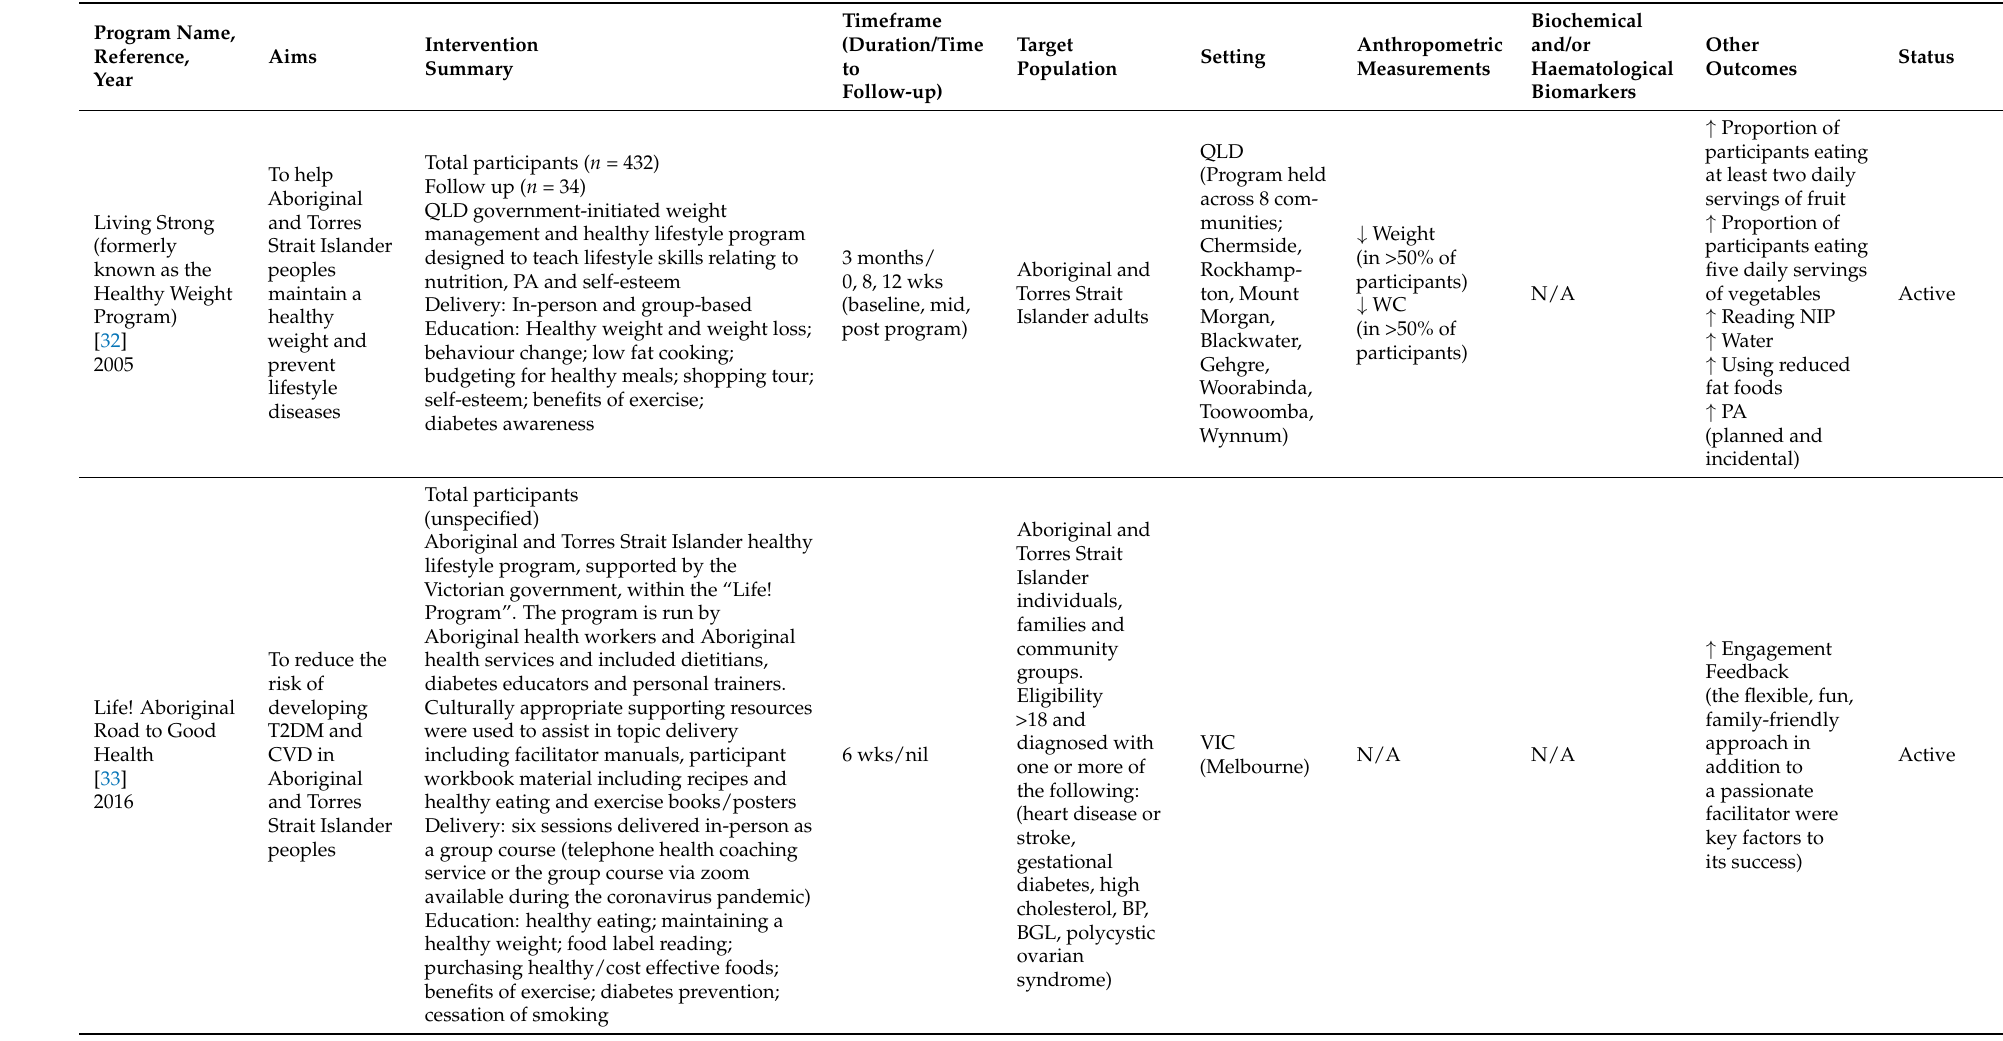
Table 1. Program characteristics for unpublished literature ( n =